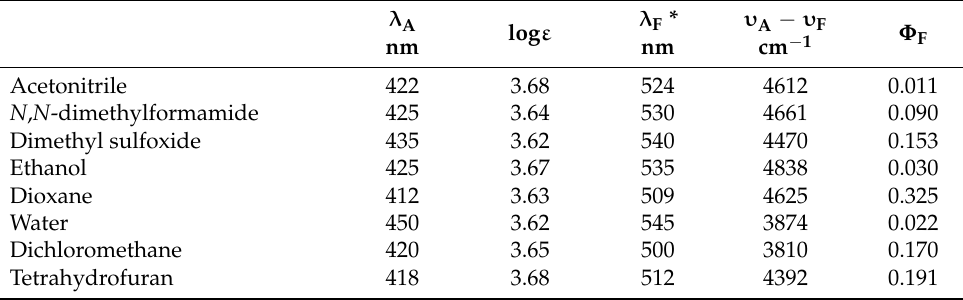
Table 2. Photophysical characterization of NI2 in organic